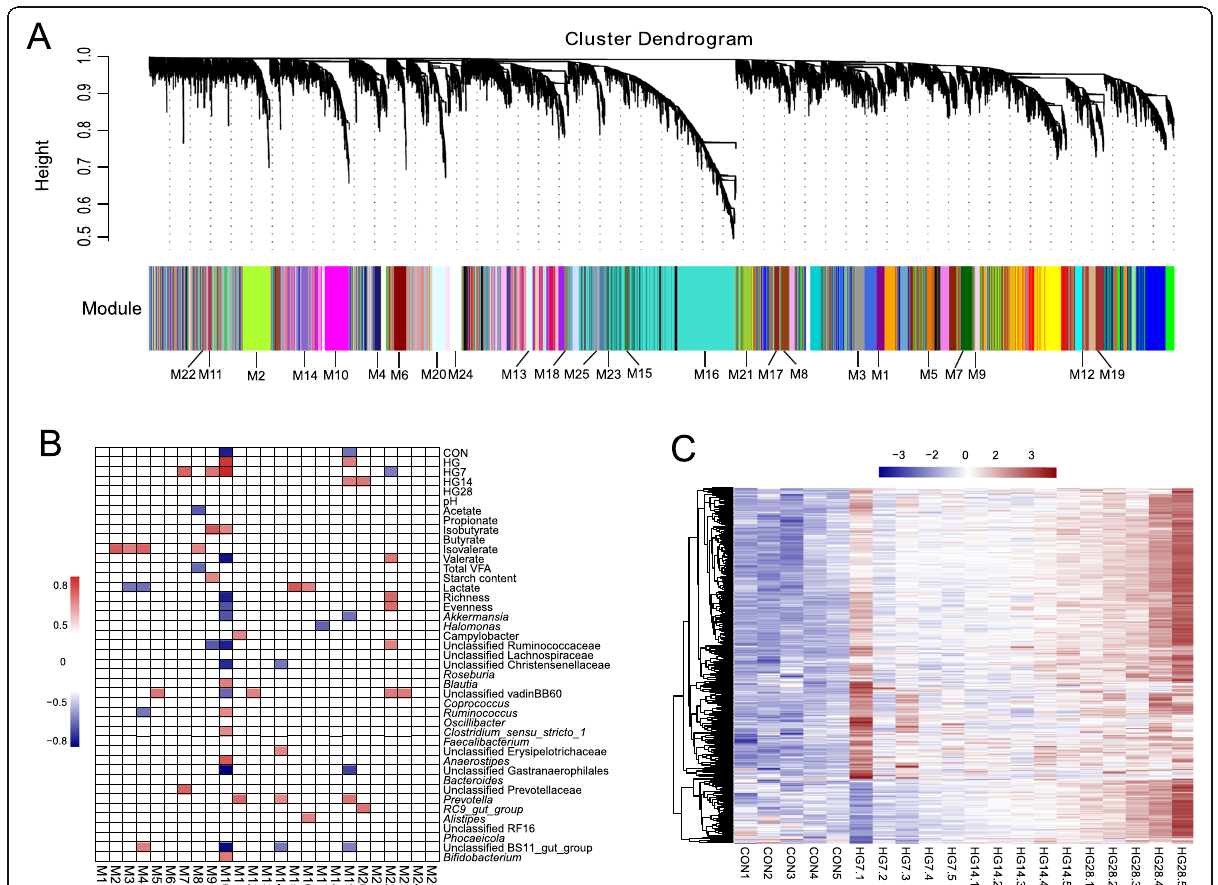
Fig. 3 Global co-expression networks and gene modules. a Dendrogram from gene co-expression network analysis of samples among the CON, HG7, HG14, and HG28 groups. Modules of co-expressed genes were assigned a color and number (M1 to M25). b Relationship between dietary factors, durations, fermentation parameters, bacterial traits, and the 25 gene modules. Only Spearman ’ s significance levels ( p < 0.05, r ≥ 0.5) are shown. c Heat map of genes in M10 showing the dynamic expression pattern after hierarchical clustering among the four groups. The color key of the heat map depicts the z-score of the expression of genes in